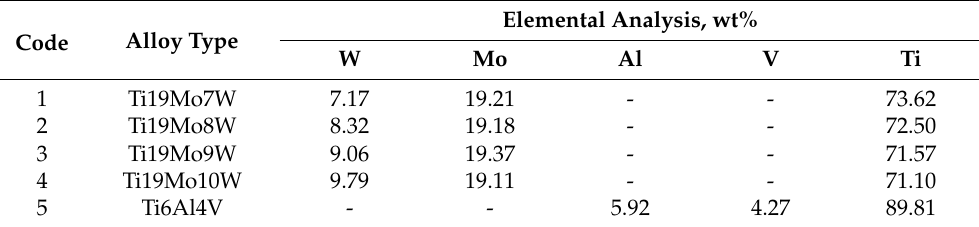
Table 2. The elemental analysis of obtained alloys.